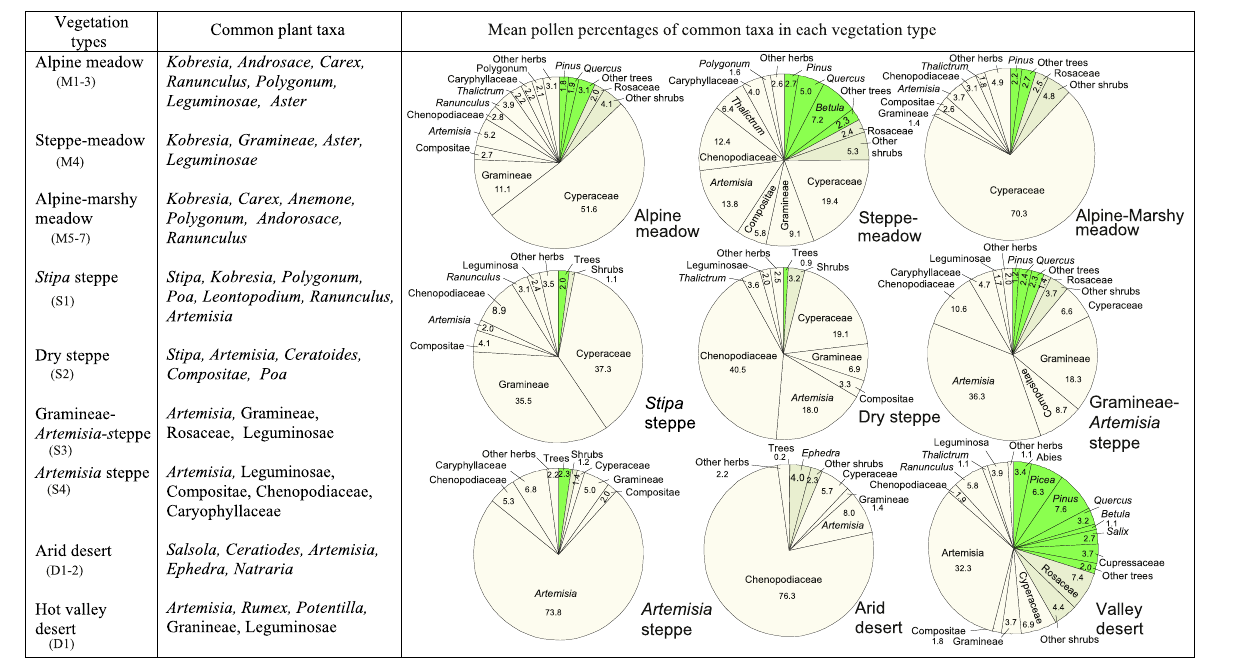
FIGURE 12 | Meadow, steppe, and desert types in the TP and their common plant taxa and representative pollen assemblages. Pie graphs in the right show the mean percentages of the common pollen taxa, calculated by averaging the pollen percentages of the corresponding taxa within each group. For meadow, steppe, and desert type classi fi cation, see Figures 6 – 8